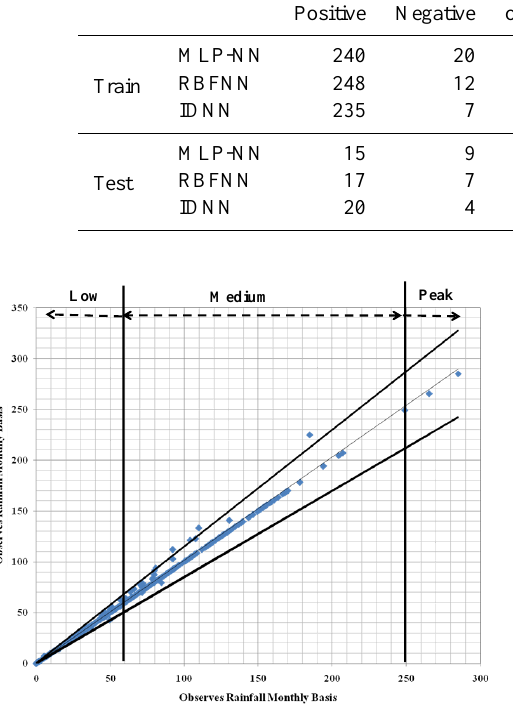
Figure 17 Forecasted and actual Rainfall on Klang River (Monthly Fig. 17. Forecasted and actual rainfall at Klang River (monthly